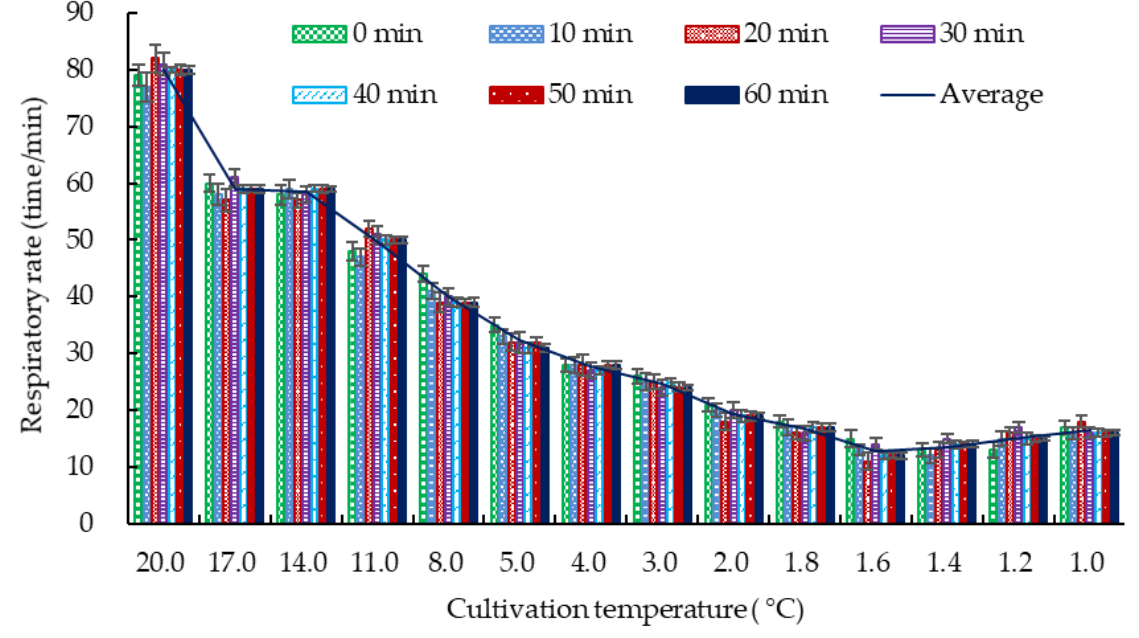
Figure 1. Effect of temperature on the respiratory rate of crucian carp.